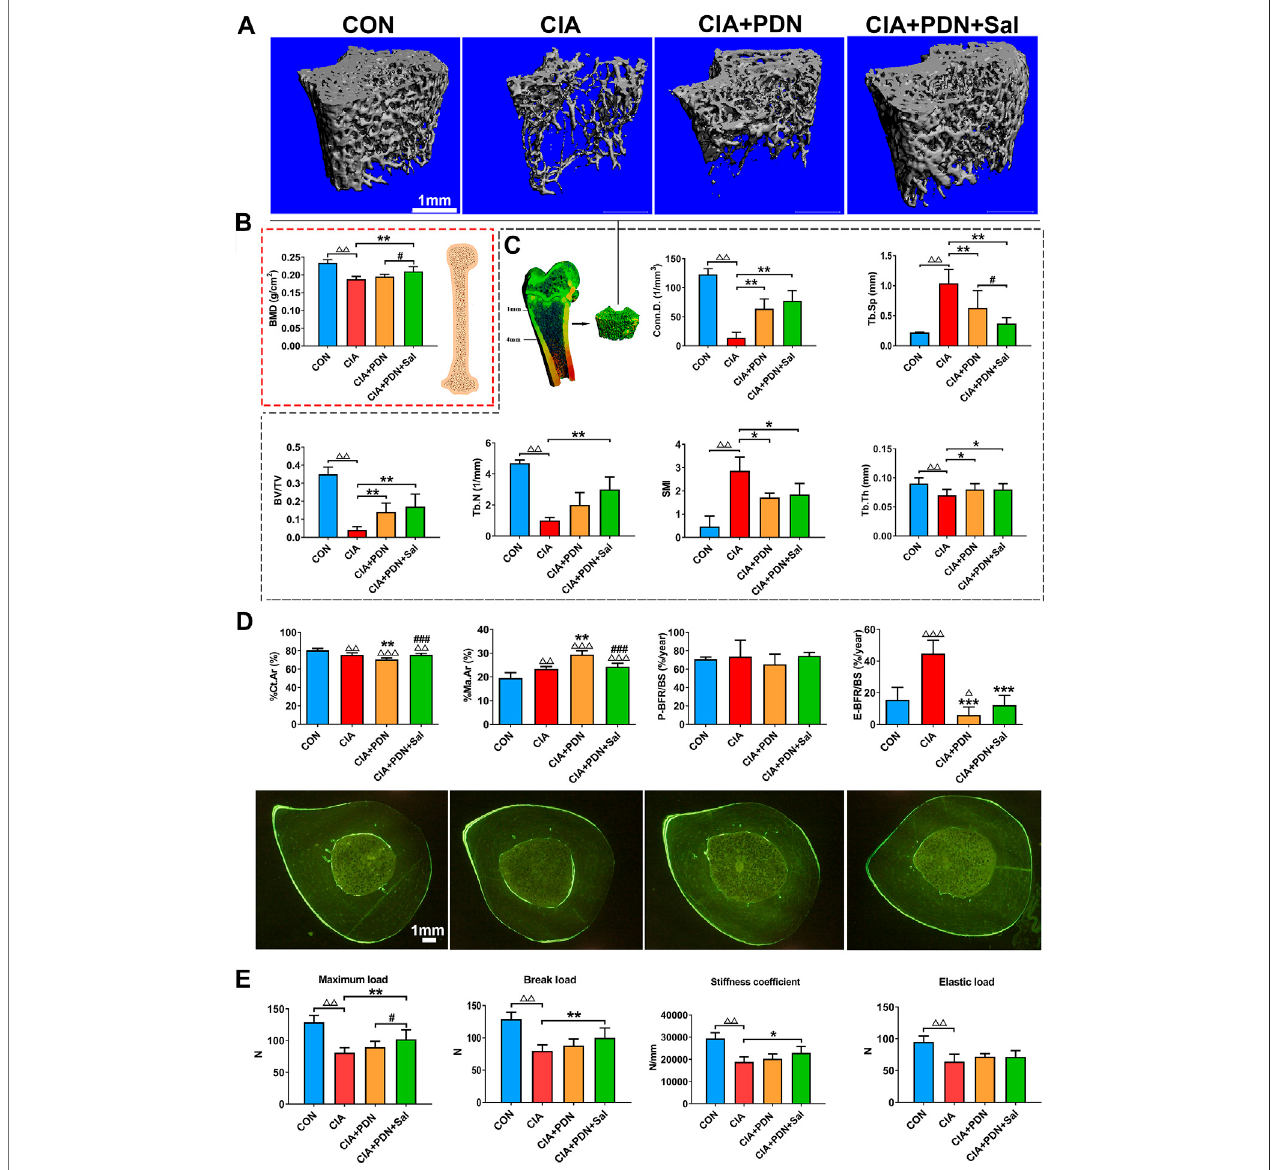
FIGURE 1 | Representative micro-CT images (A) ; micro-CT analysis of the distal femur metaphysis (B) ; BMD analyses of the whole femurs (C) ; bone histomorphometric analysis and representative images of the midshaft of the tibia (D) and bone biomechanical analysis of the femur (E) in different groups of rats. The femurswerecollectedfor BMD analysiswith adual-energy X-rayabsorptiometry system(DEX) and further used forbiomechanical analysis.The distal femur metaphysis of rats was scanned and analyzed by a micro-CT system. The midshaft of the tibia were prepared for bone histomorphometric analysis. CON: healthy control rat group; CIA:collagenII-induced arthritisratgroup; CIA+PND: prednisone-treatedCIA ratgroup; CIA+PND+Sal:combination treatment withprednisoneand salvianolate CIA rat group. ΔΔ p < 0.01 vs. CON, ΔΔΔ p < 0.001 vs CON; * p < 0.05, ** p < 0.01, *** p < 0.001 vs. CIA; # p < 0.05, ### p < 0.05 vs. CIA+PDN ( n (cid:1)